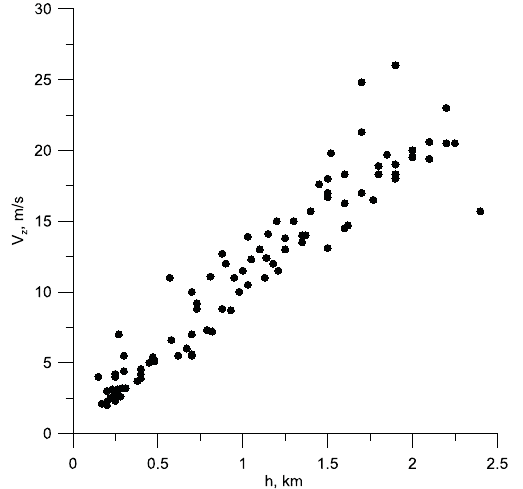
Figure 4. Amplitudes of variations of vertical velocity and displace- ment in different orbits.